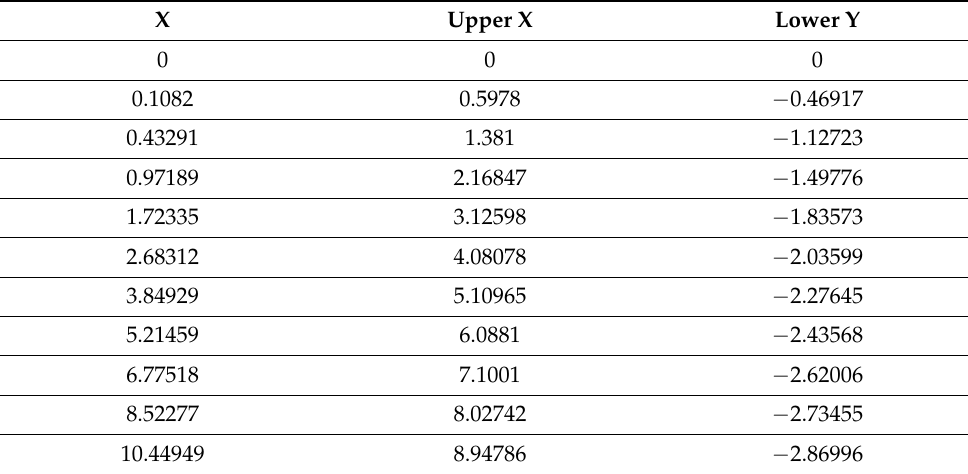
Figure 10. The two-dimensional diagram of airfoil. Table 4. Some coordinates of the FX 77-W-153 airfoil.